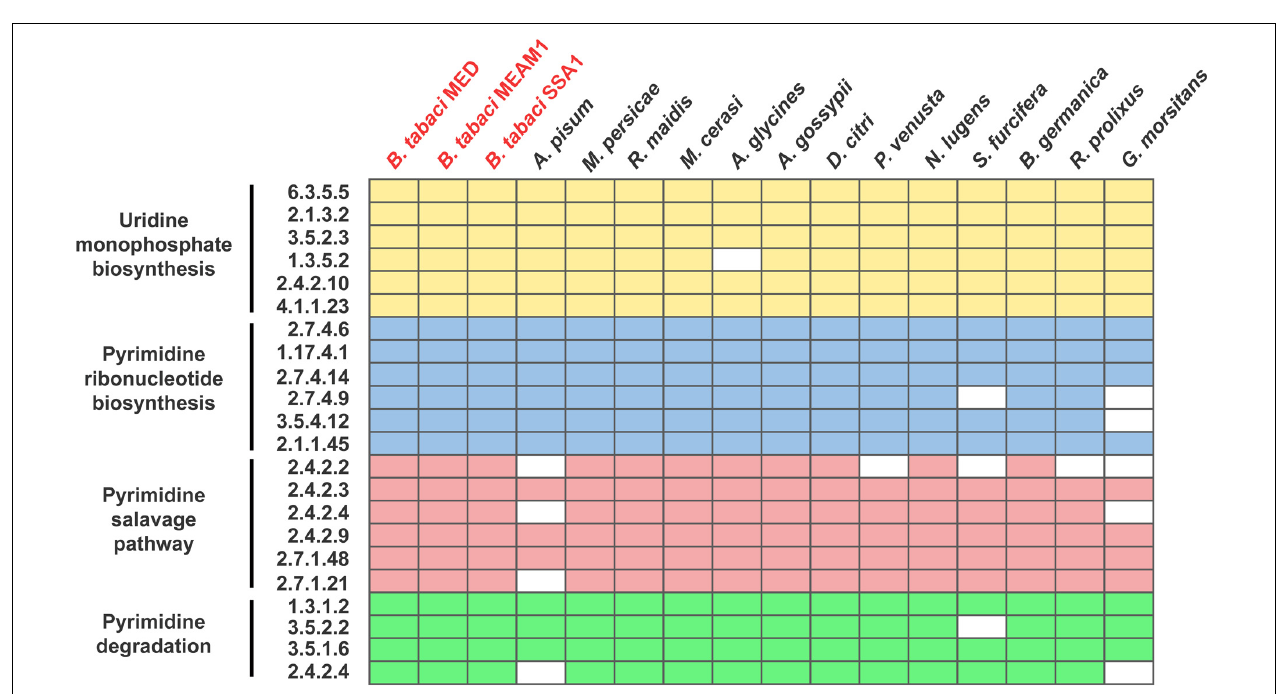
FIGURE 1 | Content of genes involved in the pyrimidine pathway of obligate symbionts. The boxes representing genes involved in uridine monophosphate biosynthesis are colored yellow; pyrimidine ribonucleotide biosynthesis, blue; the pyrimidine salvage pathway, red; and pyrimidine degradation, green. The biosynthetic processes are shown in their reaction order. The EC number of each gene is also shown. For the obligate symbiont Portiera , the genes present are colored red. Detailed information on the select symbionts is listed in Supplementary Table 1 .